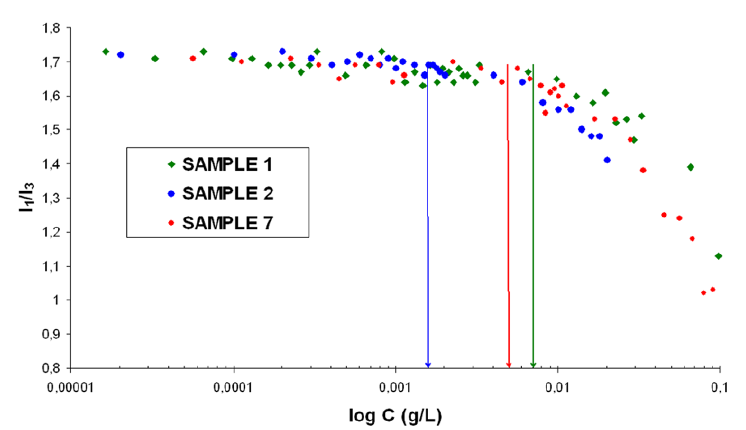
Figure 2. Plot of the I1/I3 ratio as a function of the azo-polysiloxane concentration.